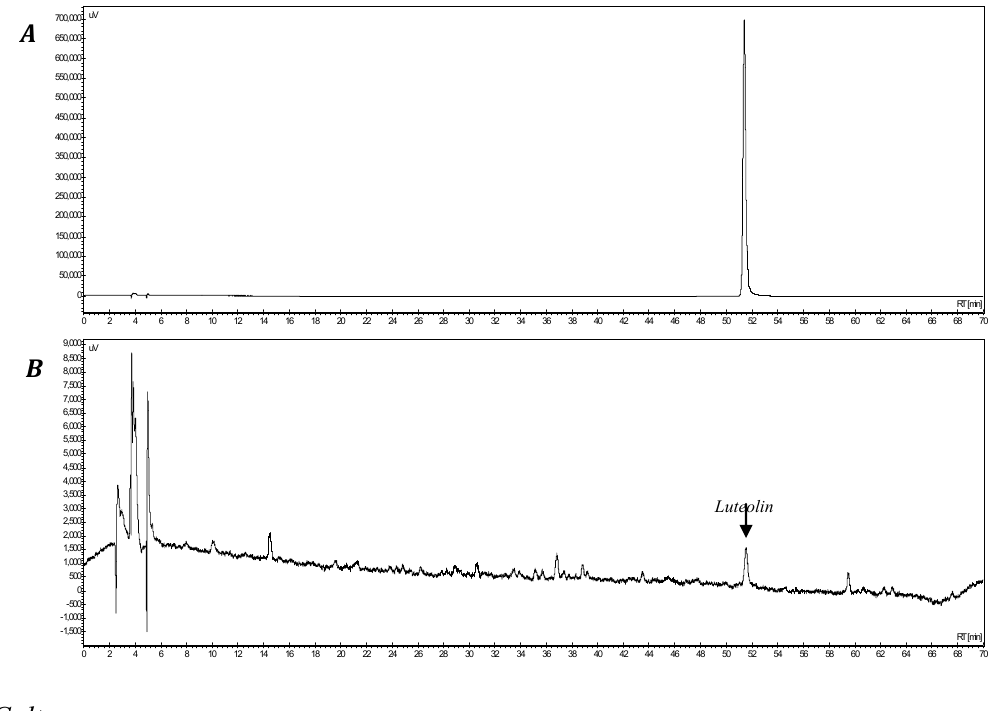
Figure 9. HPLC chromatogram of corn silk extract. ( A ) luteolin, ( B ) corn silk